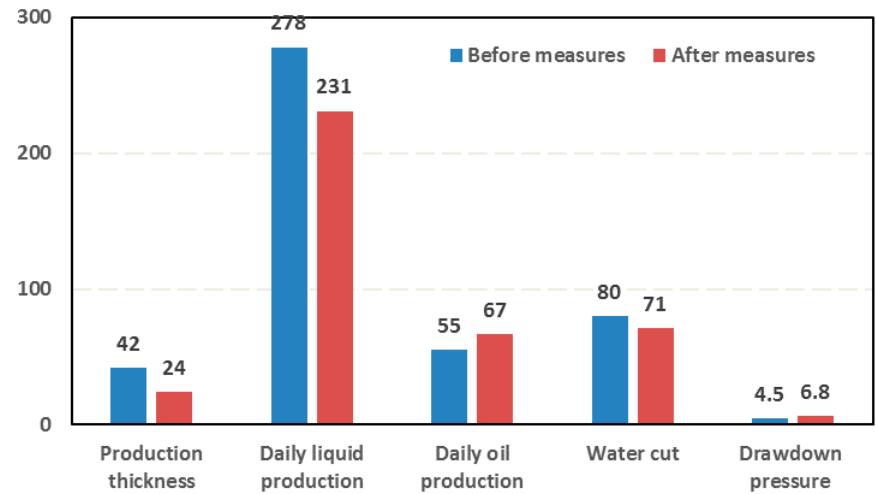
Figure 10. Comparison of the single well production index after separated production for nine months.